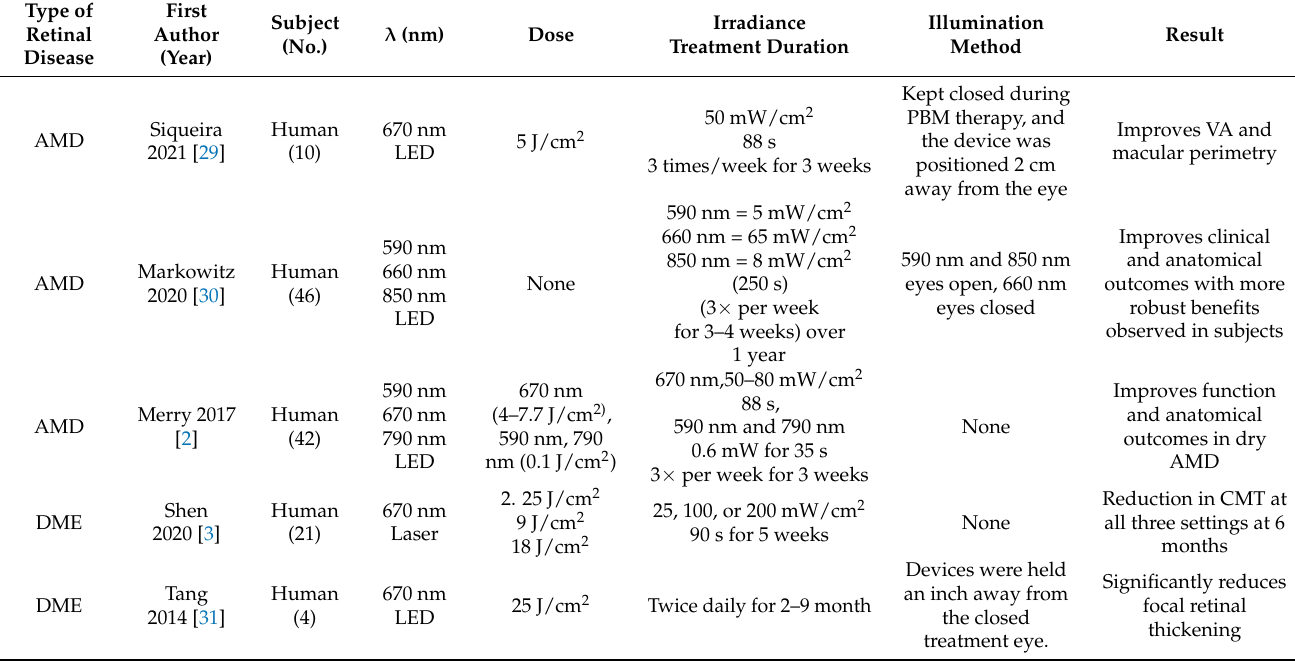
Table 2. Clinical studies on PBM for the treatment of retinal